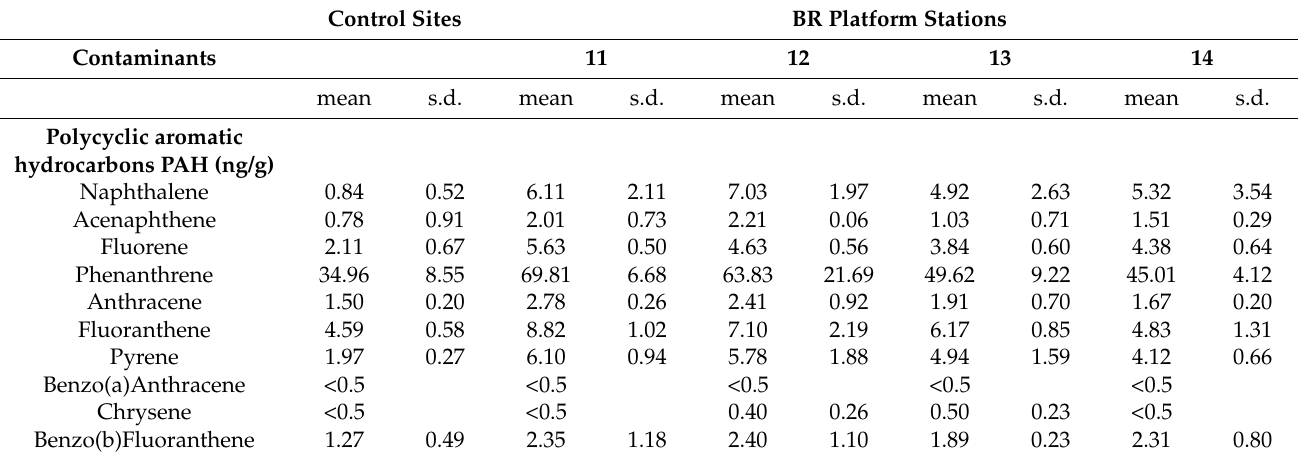
Table 3. Concentrations of contaminants in the Hediste diversicolor polychaete exposed to sediments sampled around offshore platform called BR and control sites. Mean ± standard deviation